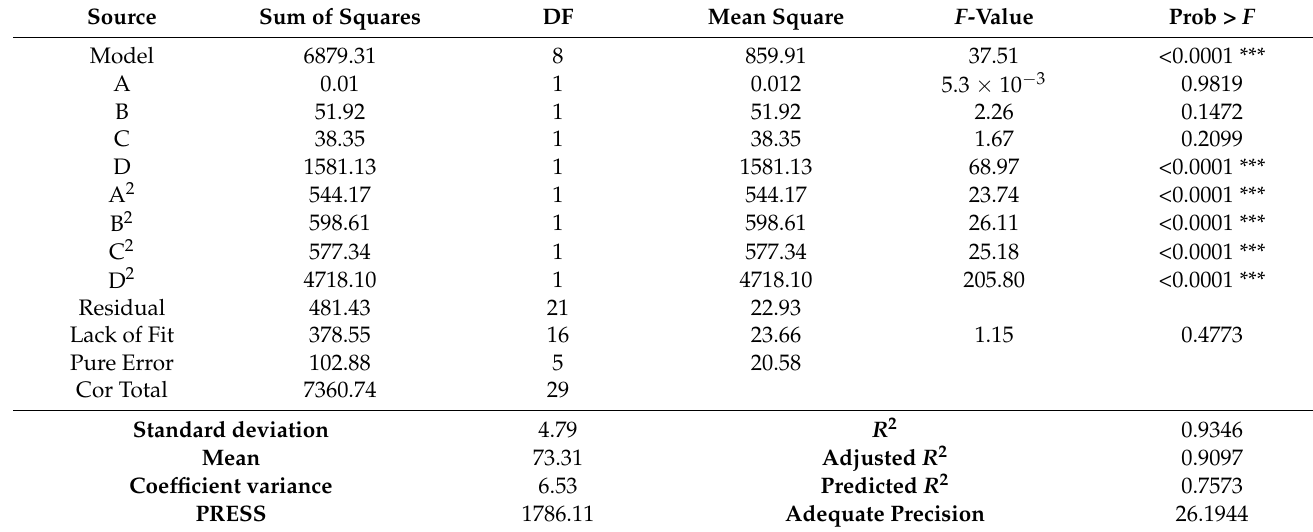
Table 3. Analysis of variance (ANOVA) of phenol degradation by the binary